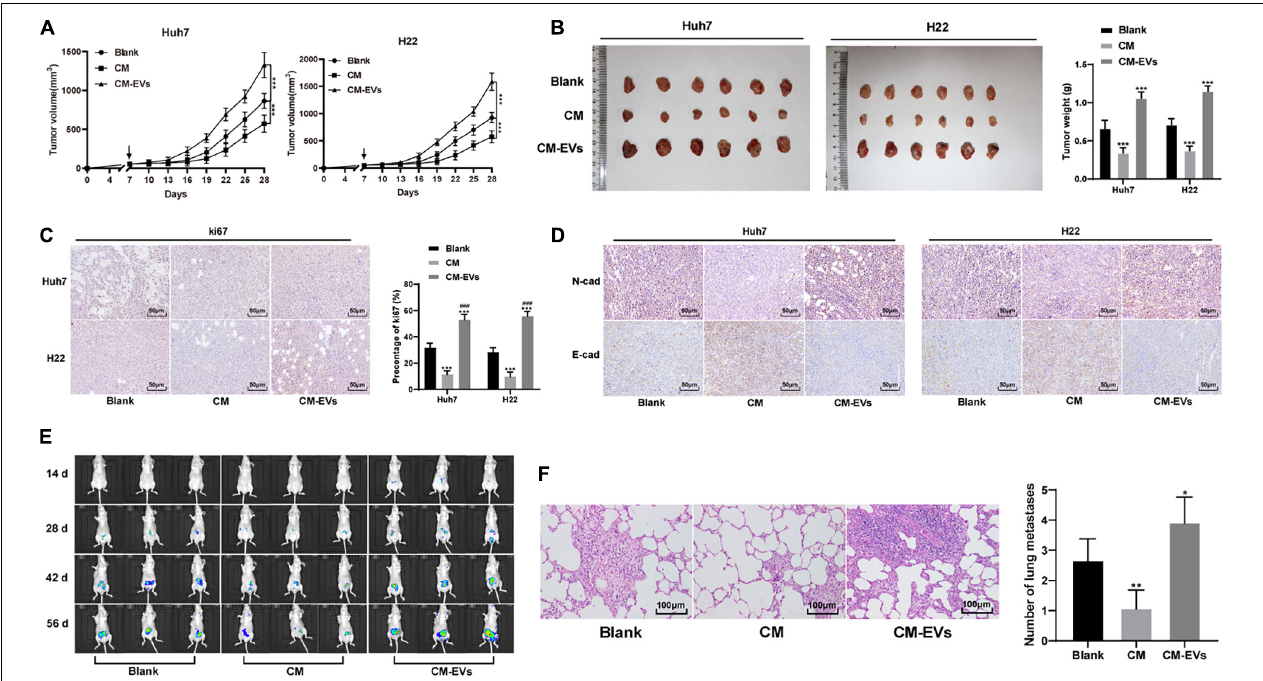
FIGURE 8 | Hepatoma cells-derived EVs undermined the therapeutic effect of BMSCs on the tumor of nude mice and promoted tumor metastasis. (A,B) Relative tumor volume and weight of nude mice after treatment, *** p < 0.001, N = 6. (C,D) immunohistochemistry detected the expression of Ki67, N-cadherin, and E-cadherin in tumors, compare with the Blank group, *** P < 0.001; compare with the CM group, ### P < 0.01, N = 6. (E) BLI imaging observed the metastasis rate of liver cancer at different time points; N = 3. (F) HE staining observed the lung metastasis rate, compare with the Blank group * P < 0.05, ** P < 0.01, N = 3. Data were analyzed by one-way ANOVA, followed by Tukey’s multiple comparison